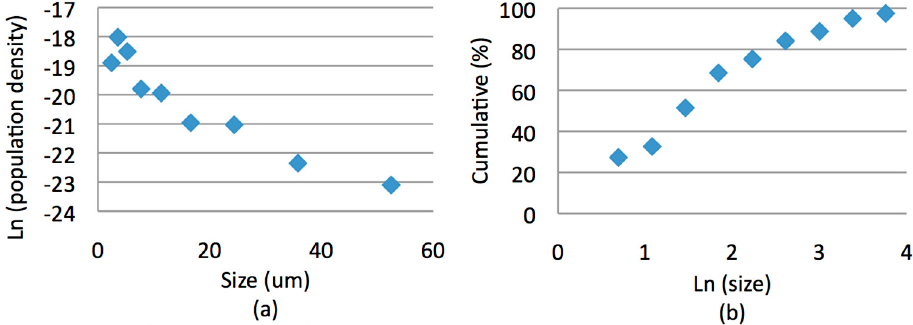
Figure 10. CSD diagrams of gold grains: ( a ) Size (length, µm) vs . Ln (population density) (mm-4). It is actually a histogram, as data are integrated over width of each size bin. Slope= − 0.08 and Intercept = 70 µm ; and ( b ) ln (size, µm) vs. Cum (%).